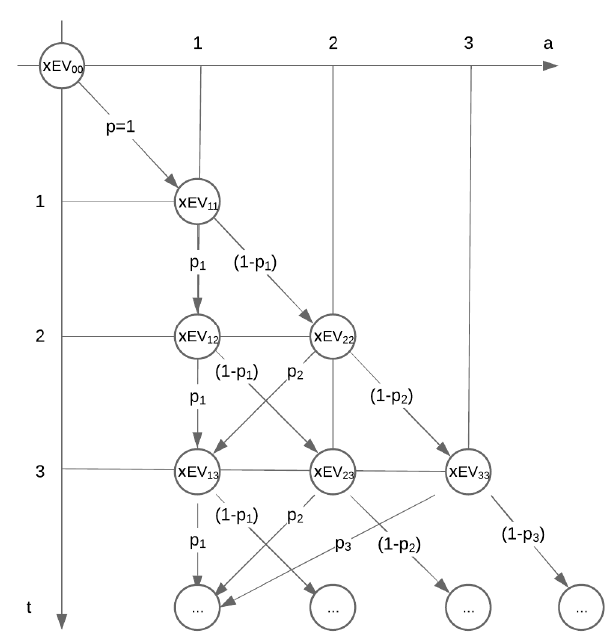
Figure 5. DTMC iterative process graph, showing the probability distribution across driving range days (axis “a”) and time (days, axis “t”).